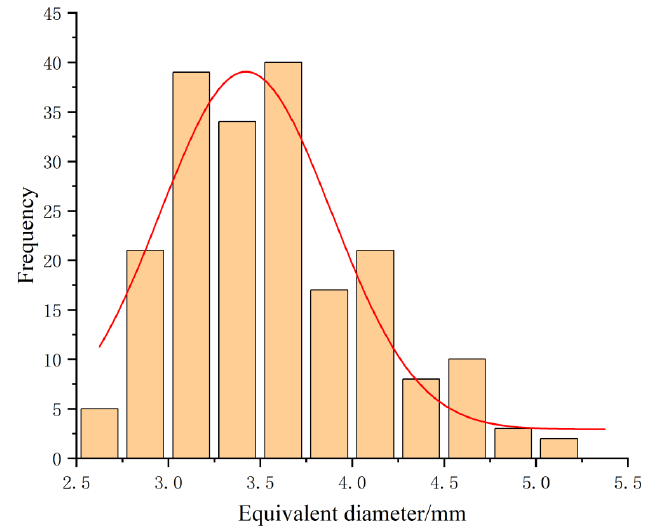
Figure 8. Particle size distribution of compound fertilizer.